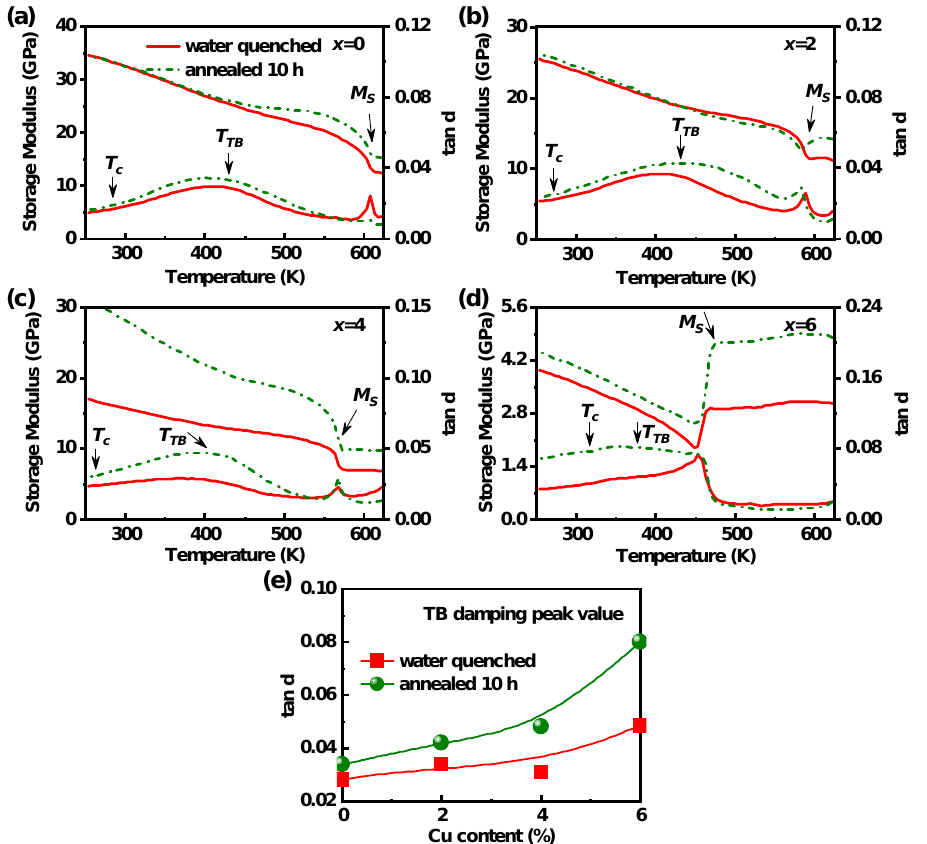
Figure 3. ( a – d ) Temperature dependence of storage modulus and internal friction for the water quenched and 10-h annealed Ni 55 − x Cu x Mn 25 Ga 20 ( x = 0, 2, 4, 6) alloys measured at 0.4 Hz. ( e ) Comparison of the TB damping peak values of water quenched and 10-h annealed Ni 55 − x Cu x Mn 25 Ga 20 ( x = 0, 2, 4, 6)